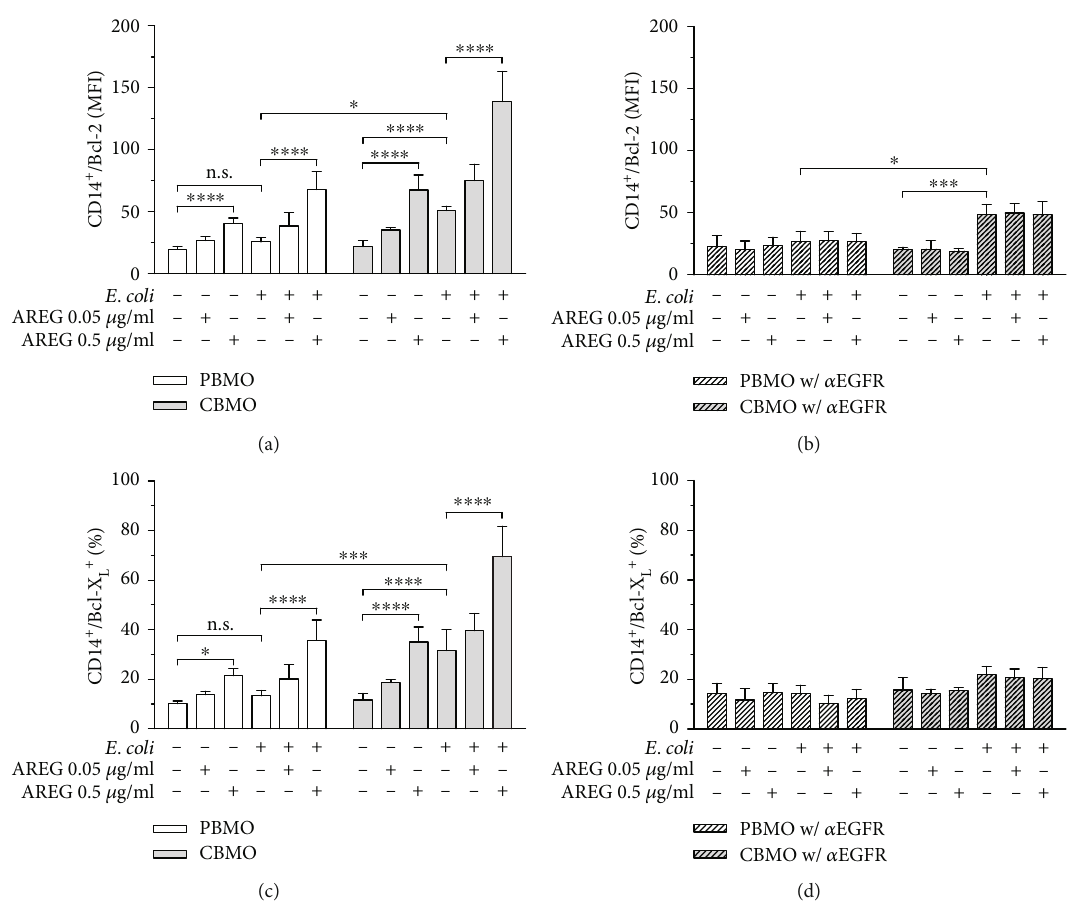
Figure 3: Bcl-2 and Bcl-X intracellular protein levels in PBMO and CMBO in response to infection, AREG stimulation, and inhibition of L EGFR. Isolated monocytes were infected with E. coli , extracellular bacteria were removed, and the cells were cultivated for 24 h in medium supplemented with antibiotics. 1h prior to infection, AREG stimulation and EGFR inhibitor treatment were started and maintained during the entire cultivation period. Quanti fi cation was performed by using fl ow cytometry. (a) Bcl-2 in PBMO and CBMO in response to infection and AREG stimulation. Bcl-2 levels are dose-dependently induced upon AREG stimulation in all settings. E. coli infection leads to an increase in Bcl-2 levels in CBMO but not in PBMO ( n = 5 ). (b) E ff ect of EGFR inhibition on Bcl-2 in PBMO and CBMO in response to infection and AREG stimulation. AREG-mediated but not infection-mediated increase in Bcl-2 levels is suppressed by EGFR inhibition ( n = 4 ). (c) Bcl-X in PBMO and CBMO in response to infection and AREG stimulation. AREG stimulation dose-dependently increases L Bcl-X levels in both groups, while E. coli infection increases Bcl-X solely in CBMO ( n = 5 ). (d) E ff ect of EGFR inhibition on Bcl-X L L L levels in PBMO and CBMO in response to infection and AREG stimulation. AREG and infection-mediated increase in Bcl-X levels is L abolished by EGFR inhibition ( n = 4 ). Data are shown as means + SD . Statistical signi fi cance was analyzed using two-way ANOVA with Bonferroni ’ s multiple comparisons test. n.s.: not signi fi cant. ∗ p < 0 : 05 ; ∗∗∗ p < 0 : 005 ; and ∗∗∗∗ p < 0 : 001